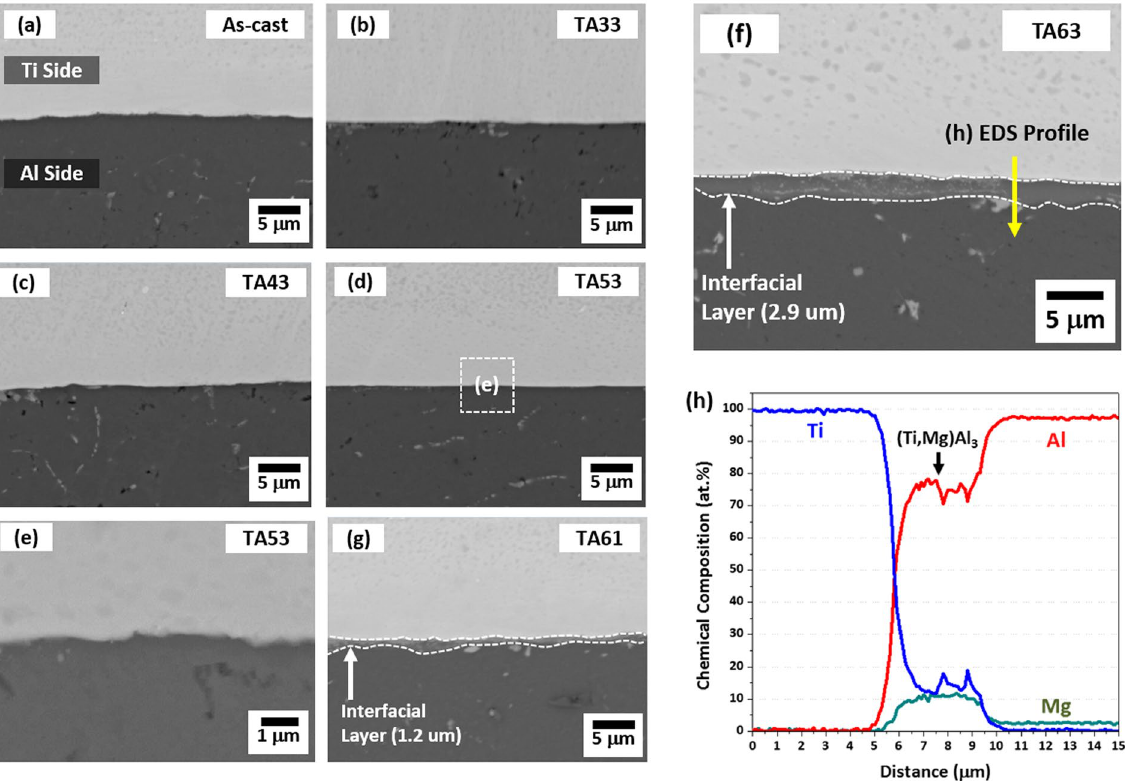
Figure 2. Microstructures of twin-roll-cast and annealed Ti/Al clad sheets. SEM micrographs of the cross- sectional area of the ( a ) as-cast specimen and ( b–f ) specimens annealed at 350 °C, 400 °C, 500 °C, and 600 °C for 30 min (TA33, TA43, TA53, and TA63 specimens, respectively). The interfacial reaction layer thickness is about 2.9 μ m, which is thicker than that (1.2 μ m) of the TA61 specimen, as shown in ( g ). The EDS data of the interfacial reaction layer of the TA63 specimen is shown in ( h ), and indicate that the layer is composed of (Ti,Mg)Al